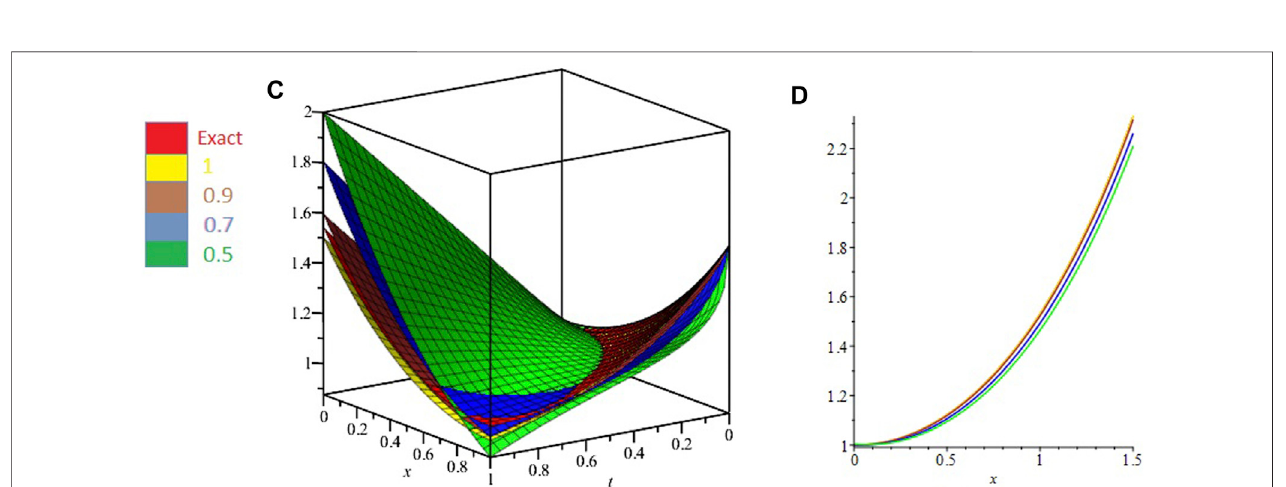
FIGURE 2 | ETDM ] -solution (C) 3D and (D) 2D graph at various values of α and β